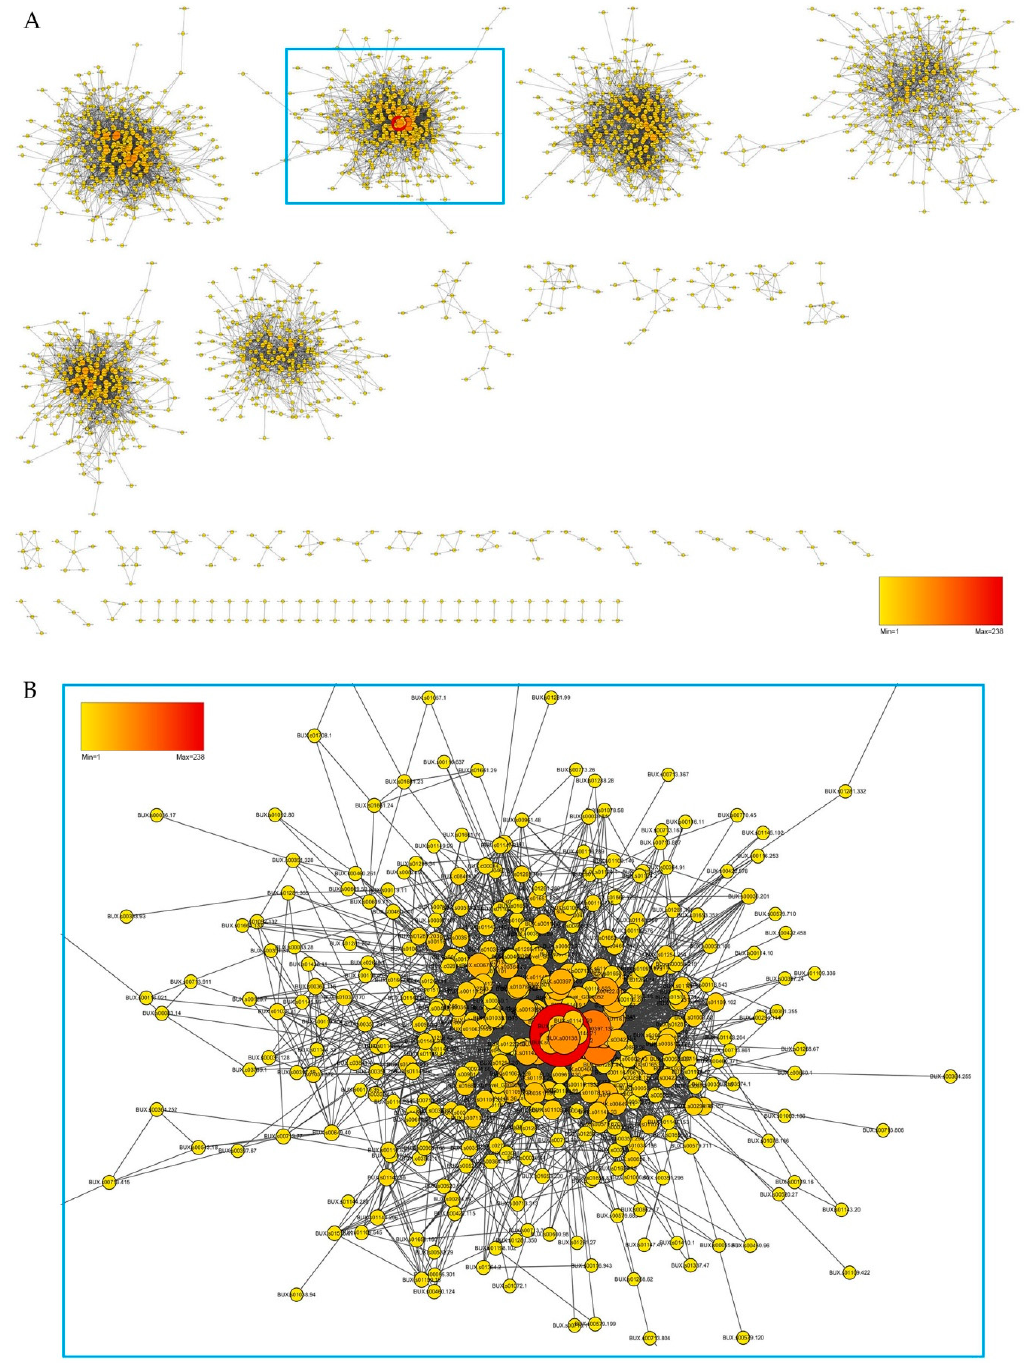
Figure 8. Interactions of proteins encoded by differentially expressed genes of B. xylophilus between aseptic condition and with S. maltophilia . Protein interactions of all differentially expressed genes ( A ); enlarged view of protein interactions ( B ). The larger the circle and the redder the color, the more proteins interacted with the protein, and the smaller and yellow the fewer interactions.